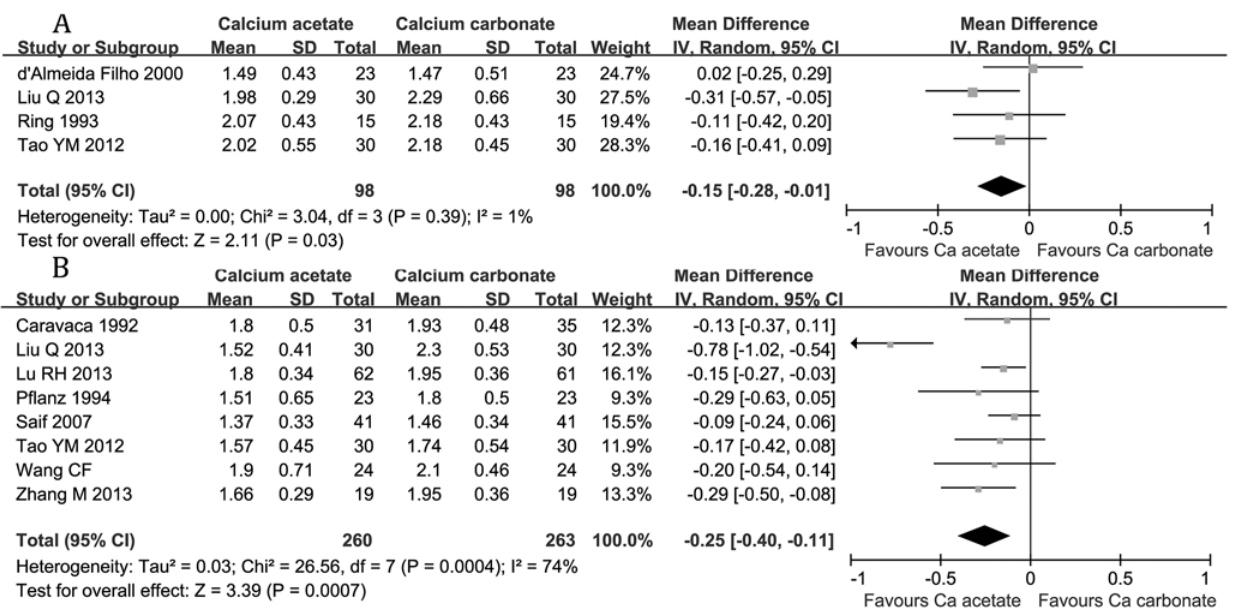
Fig 2. Serum phosphorus levels after 4 weeks (A) or 8 weeks (B) administration of calcium-based phosphate